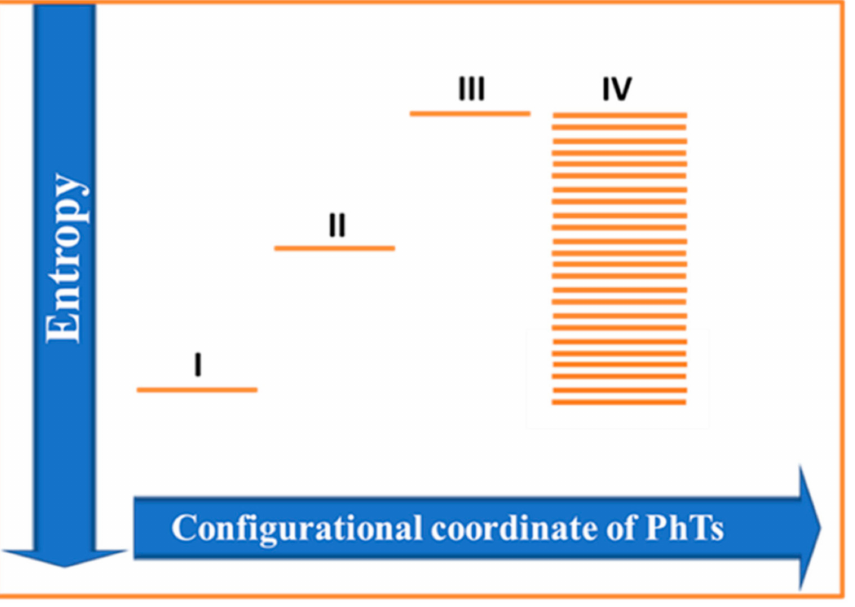
Figure 2. Schematic representation of entropy-driven protein self-assembly. From a statistical per- spective, racemization is associated with increase in entropy, whereas protein folding is accompanied by the entropy decrease. Distinct states of protein configuration. I—Free AAs (cytosol). II—Unfolder chain of AAs. III—Native state (NS) of ordered globular protein. IV—The set of discrete states reflects the different degrees of spontaneous racemization and illustrates the complexity of the resulting outputs of such racemization. Importantly, spontaneous racemization and spontaneous protein folding are associated with Gibbs’s free energy decrease. The sequences of phase transitions I-II-III and III-IV are both related to the decrease in the Gibbs free energy but the opposite behavior of entropy. Although the discrete stepwise entropy reduction due to protein condensation (folding) is well-known, the increase in entropy due to the spontaneous racemization is mostly overlooked. Ar- rows on the right side of the diagram schematically represent degrees of the racemization one would expect during the lifetime of an organism (metabolically active state) and spontaneous complete postmortem racemization (metabolically inactive